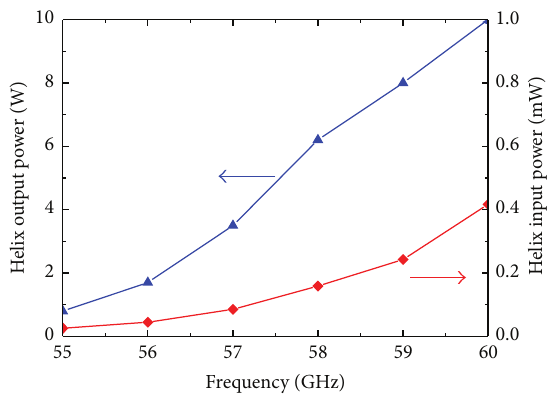
Figure 12: Helix output and input power curves to meet FW saturated input power.